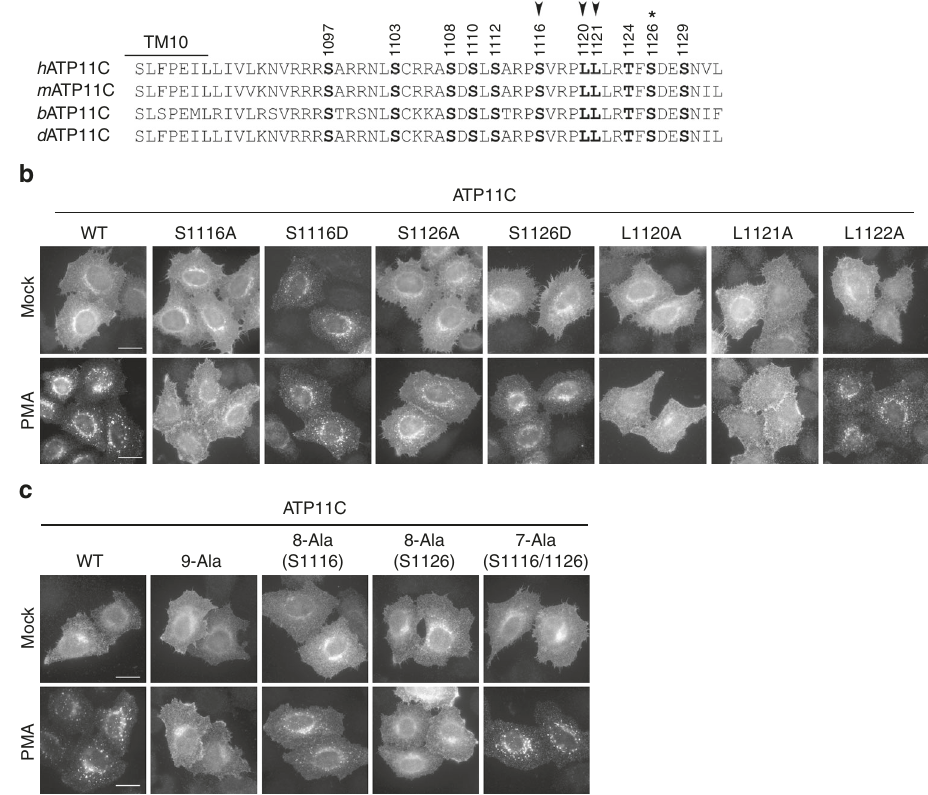
Fig. 6 Ser1116, Leu1120, and Leu1121 serve as a di-leucine signaling motif upon PKC activation. a Alignment of amino acid sequences of the C-terminal cytoplasmic region of mammalian ATP11C. Serine and threonine residues shown in bold were conserved among human ( h ), mouse ( m ), bovine ( b ), and dog ( d ). Arrowheads exhibit critical residues for endocytosis, and the residue marked with an asterisk is involved in endosomal localization of ATP11C after PKC activation. b HeLa cells were transiently co-transfected with expression vectors for FLAG-tagged CDC50A and HA-tagged WT of ATP11C, or mutants of HA-tagged ATP11C, in which each bold residue in a was replaced with alanine (see also Supplementary Fig. 3a) or aspartate. c HeLa cells were transiently co-transfected with expression vectors for FLAG-tagged CDC50A and HA-tagged WT of ATP11C, or mutants of HA-tagged ATP11C. In the mutants, alanine replaced all serine and threonine residues in the C-terminus of ATP11C shown in a (9-Ala), all except Ser1116 (8-Ala(S1116)), all except Ser1126 (8- Ala[S1126]), or all except Ser1116 and Ser1126 (7-Ala(S1116/1126)). b , c The cells were treated with vehicle alone (Mock) or 400 nM of PMA (PMA) for 15 min and fi xed. The fi xed cells were then incubated with anti-HA antibody, followed by incubation with Cy3-conjugated anti-rat secondary antibody.